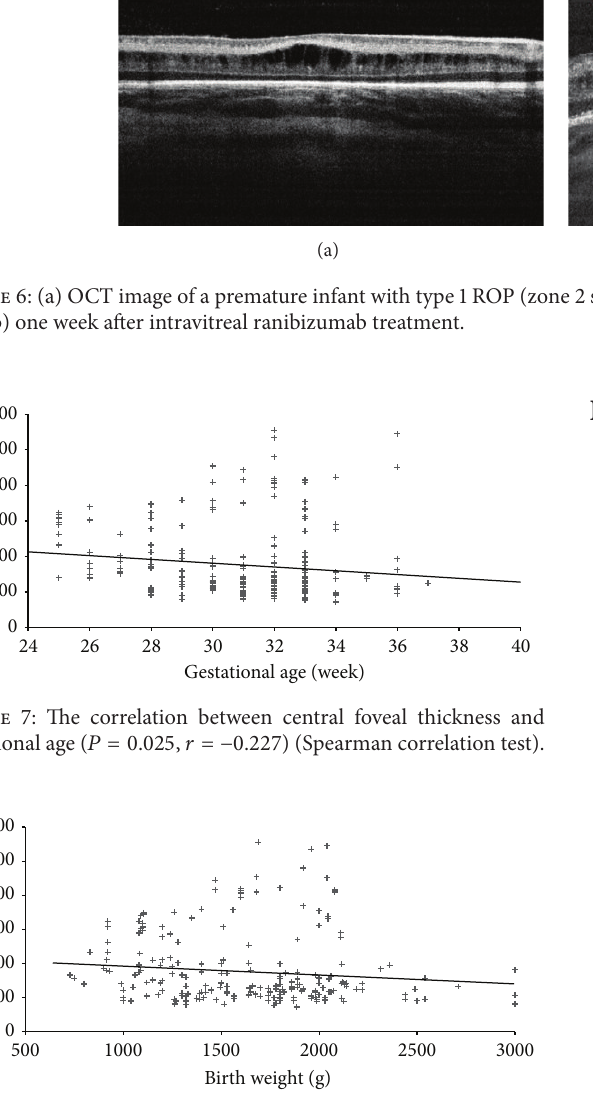
Figure 8: The correlation between central foveal thickness and birth weight ( 𝑃 = 0.002 , 𝑟 = −0.182 ) (Spearman correlation